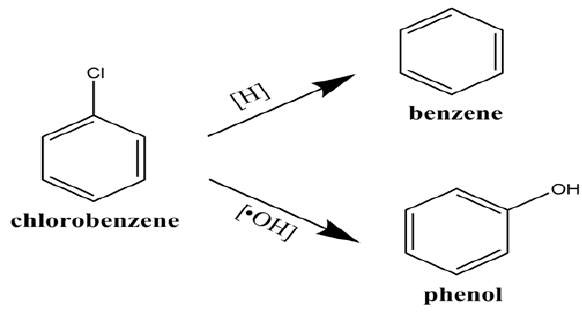
Figure 10. The main chlorobenzene degradation mechanisms during the Fe-Cu/biochar treatment.